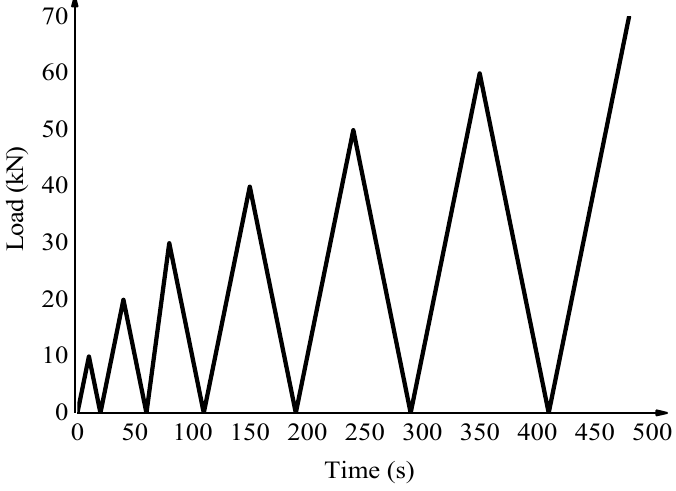
Figure 2. Stress path of cyclic loading test.